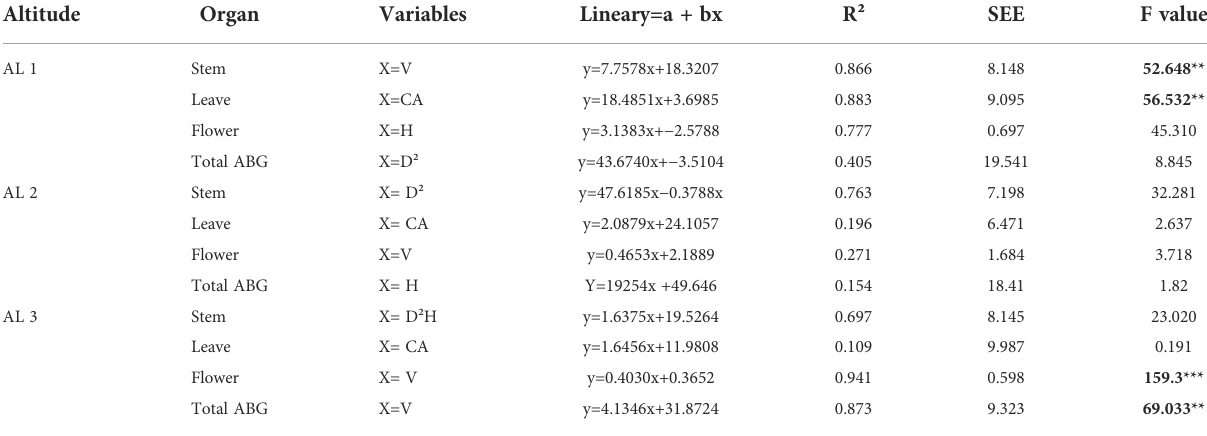
TABLE 3 Linear model for Calotropis procera organ with biomass at different habitat. Altitude